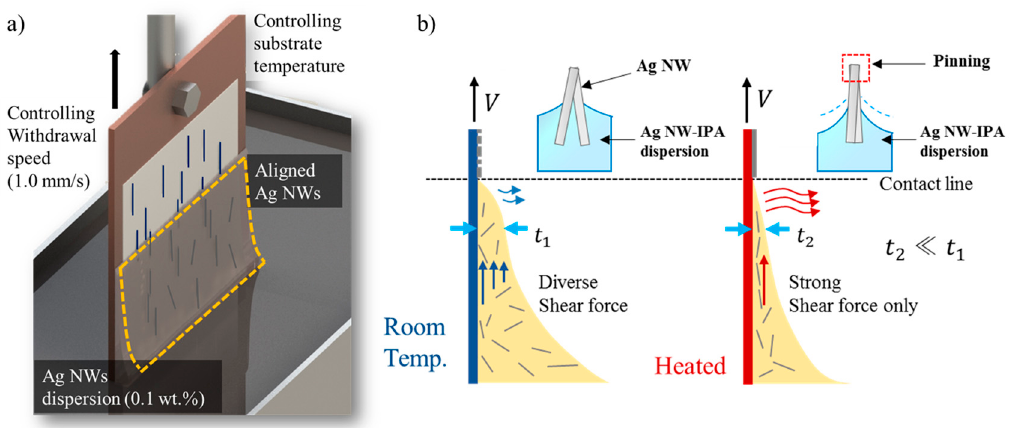
Figure 3. The principle of alignment of the silver nanowires. ( a ) Process schematic. ( b ) Principle of the alignment of silver nanowires in the temperature-controlled dip coating process.